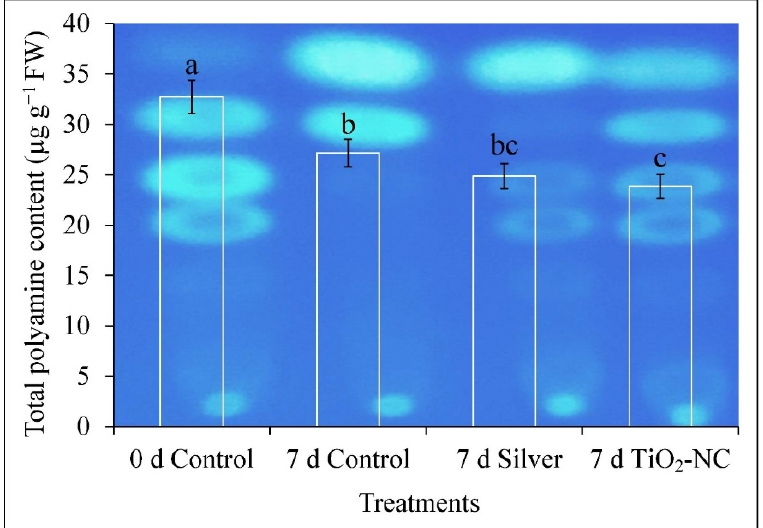
Figure 7. Separation and identification of total polyamine from Capsicum fruit on TLC plate and resolved under UV illumination under silver and TiO 2 -NC with respect to control during 0 d and 7 d of postharvest storage at 25 °C. Vertical bars showing SE ± 1 ( n = 3) on each column and letters above bars indicate statistical variations between treatments based on one way ANOVA ( p ≤ 0.05).